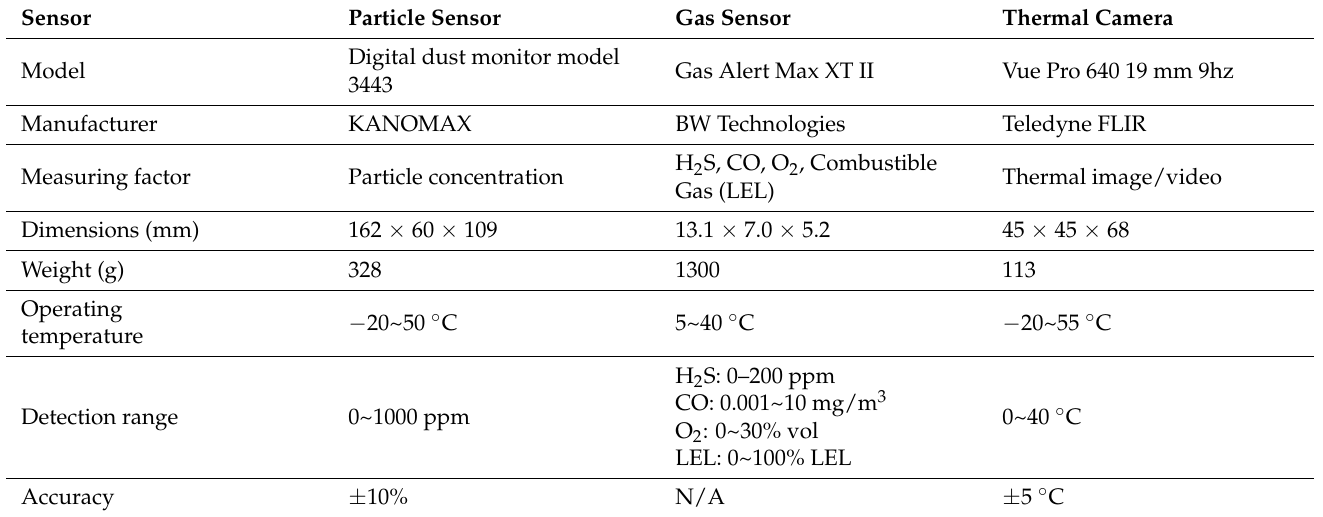
Table 3. Specifications of environmental sensors used in this study.